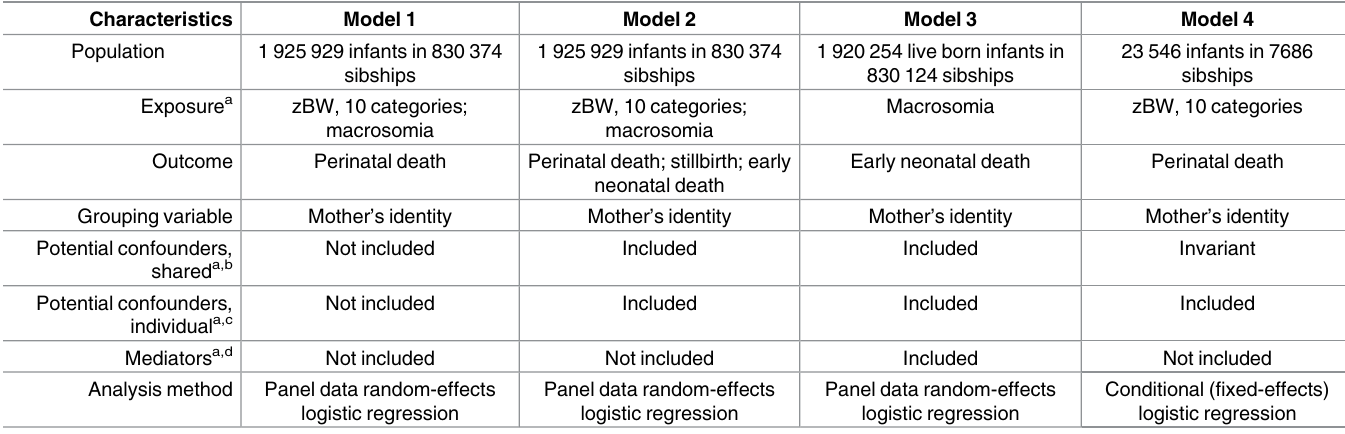
Table 1. Characteristics of four models applied in the